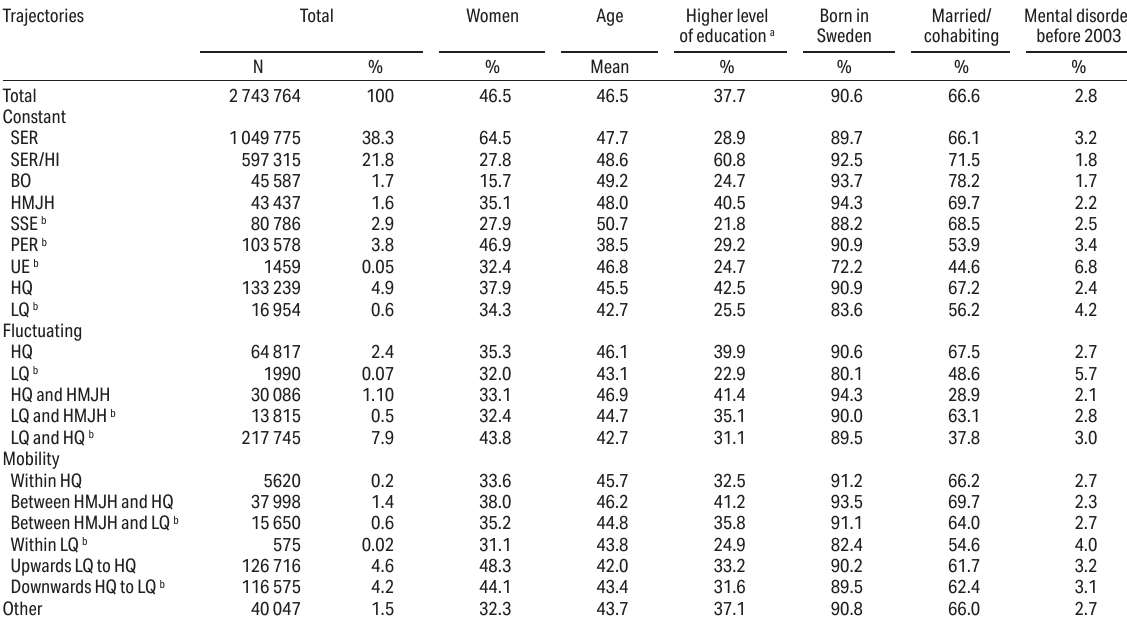
Table 2. Characteristics of cohort (2009) according to employment trajectories. [UE=unemployment; PER=precarious employment relation - ship; SSE=solo self-employment; HMJH=hybrid multiple job-holding; BO= business ownership; SER= standard employment relationship; SER/ HI=standard employment relationship with high income; LQ=low quality; HQ=high